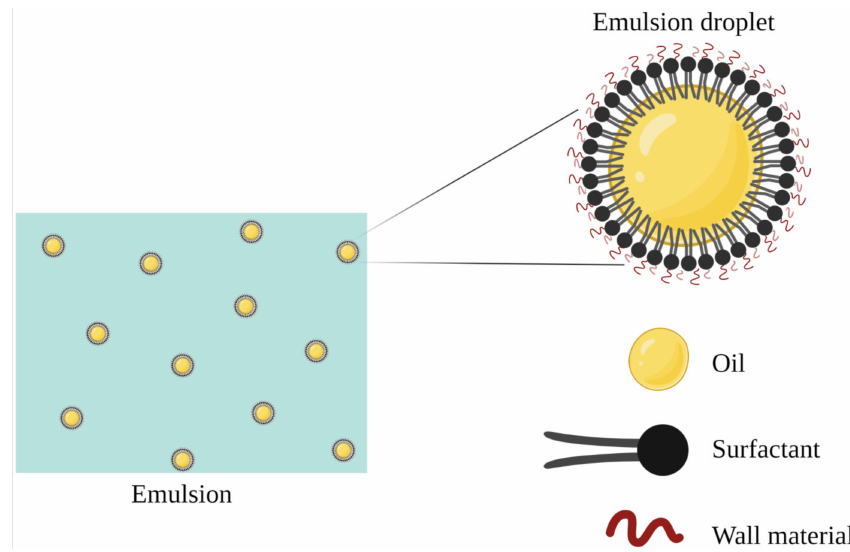
Figure 3. Scheme representing the structure of emulsions and their stability in